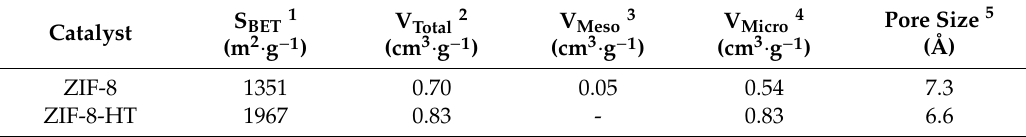
Figure 4. Nitrogen adsorption isotherms ( A ) and pore size distributions ( B ) of ( a ) ZIF-8 and ( b ) ZIF-8-HT measured at 77 K. Table 2. Textural properties of the catalysts obtained from nitrogen adsorption analysis.